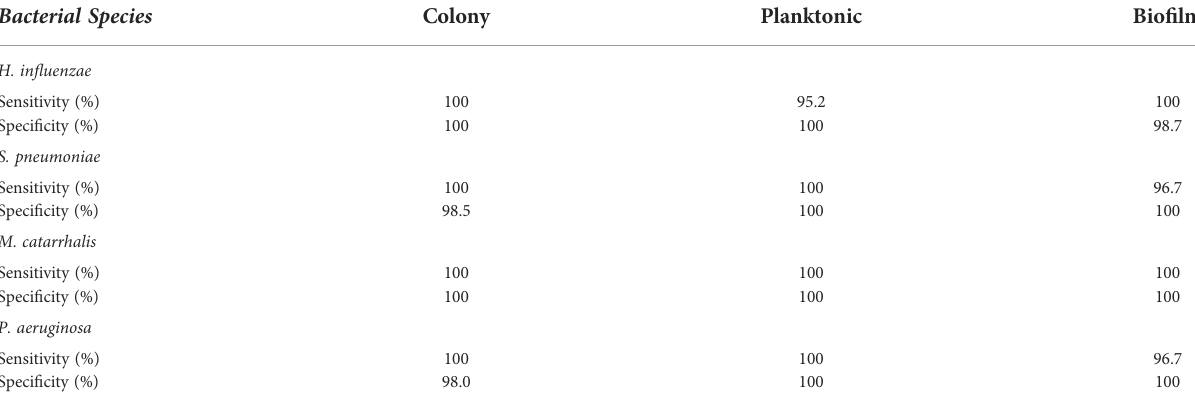
TABLE 1 A summary of the sensitivity and speci fi city for SMLR differentiation of three different growth environments for individual bacterial species using RS. Bacterial